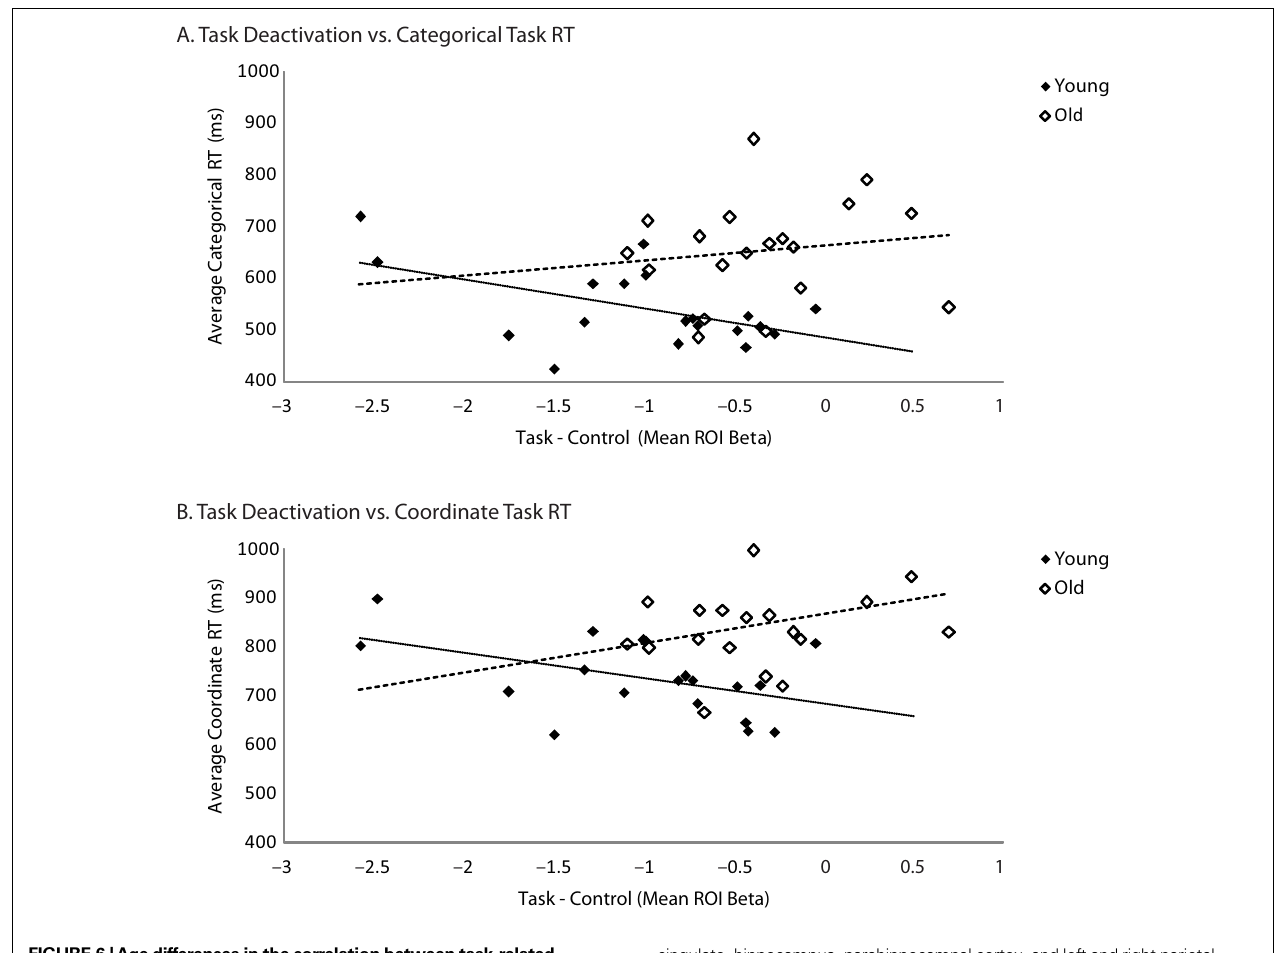
cingulate, hippocampus, parahippocampal cortex, and left and right parietal cortex). (B) Coordinate task RT as a function of task–control contrast betas averaged across same